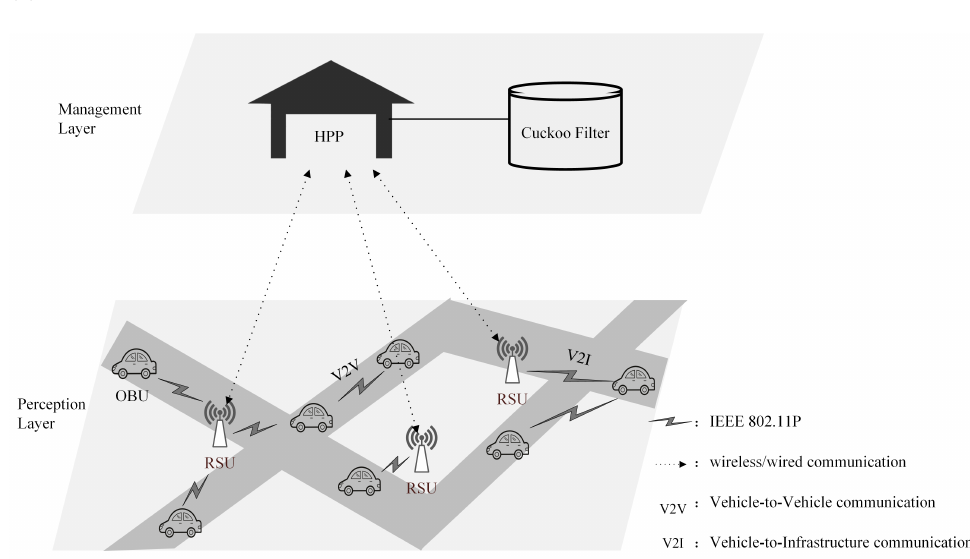
Figure 1. System